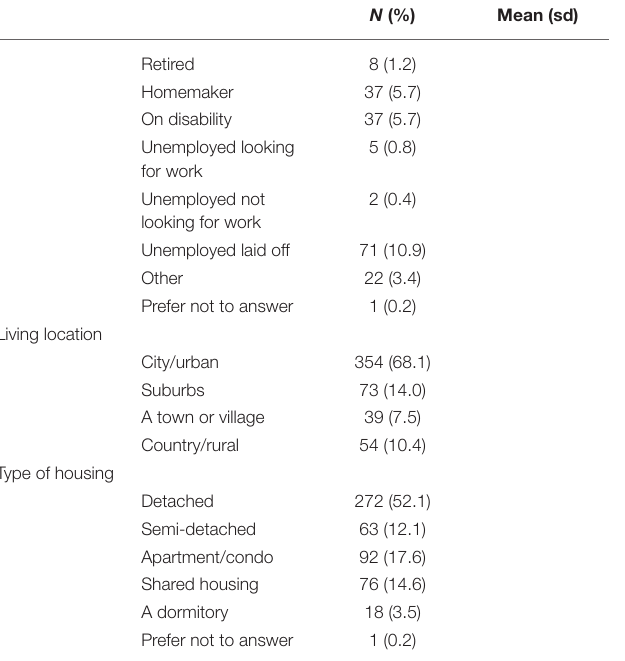
TABLE 2 | Correlations between mental health, gender, age, BMI, and change in